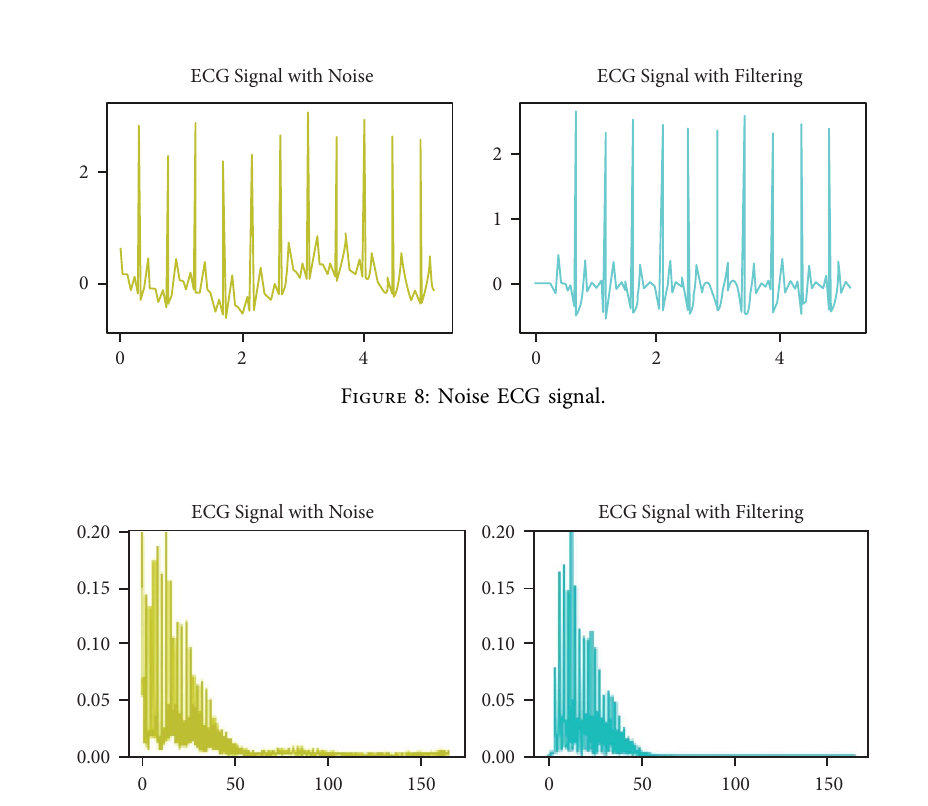
Figure 7: 1-D and 2-D ECG signals dataset.